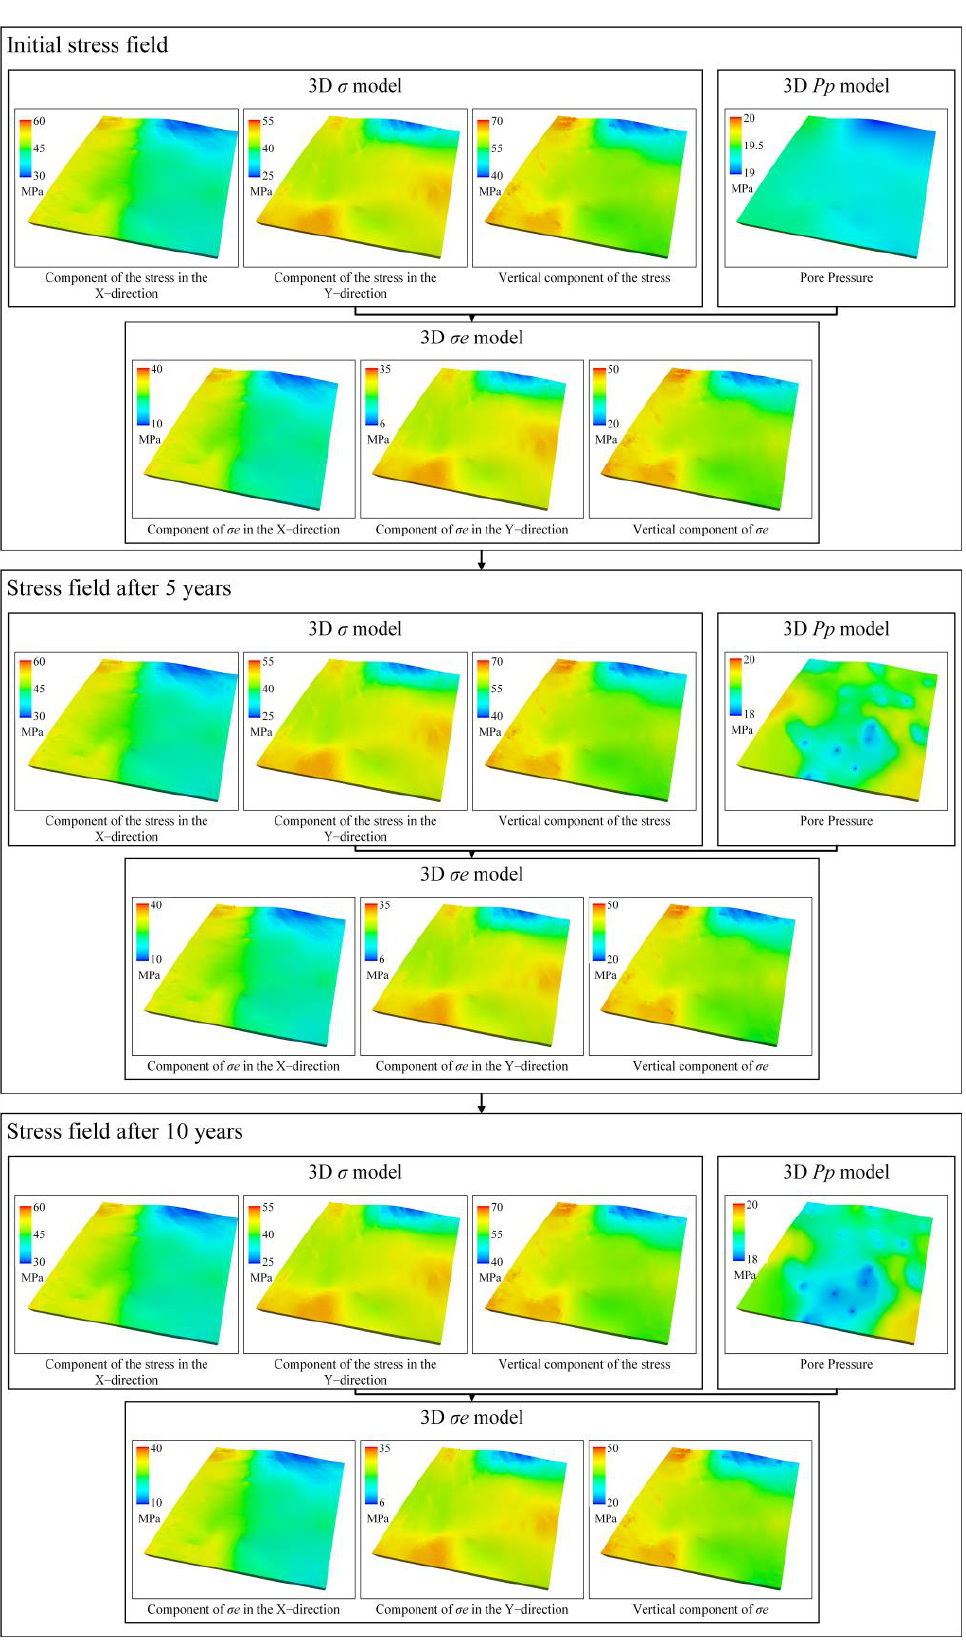
Figure 7. Dynamic stress field model for well area X established through reservoir–geomechanics coupling.